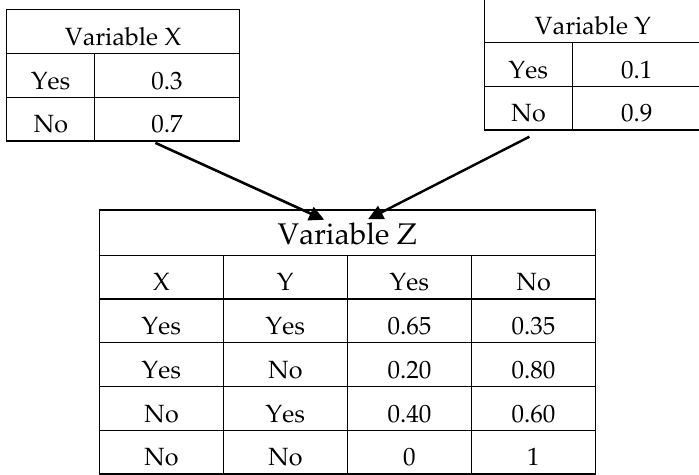
Figure 1. An example of a Bayesian Network structure and the Conditional Probability Tables (CPT).